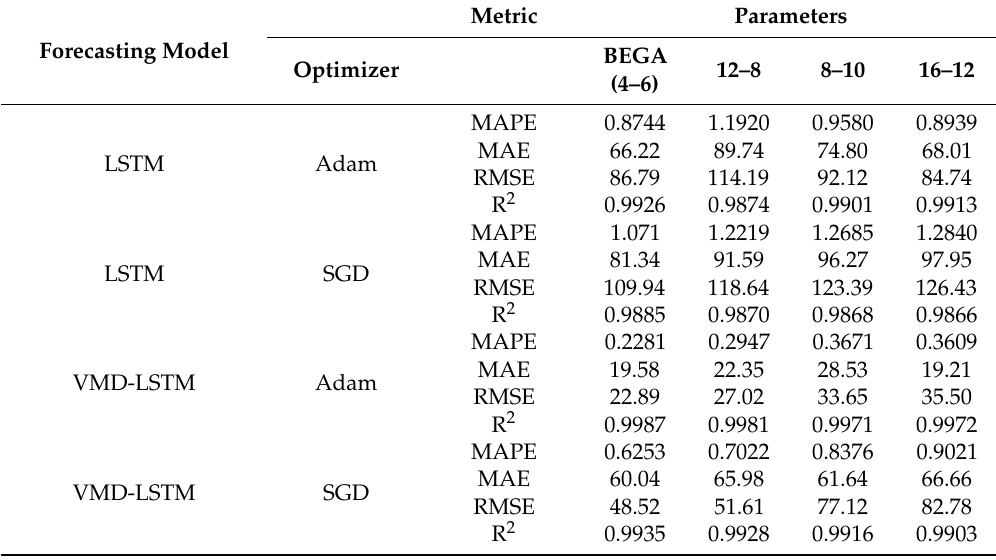
Table 12. Comparison of the performance results of di ff erent optimizers based on the NSW spring